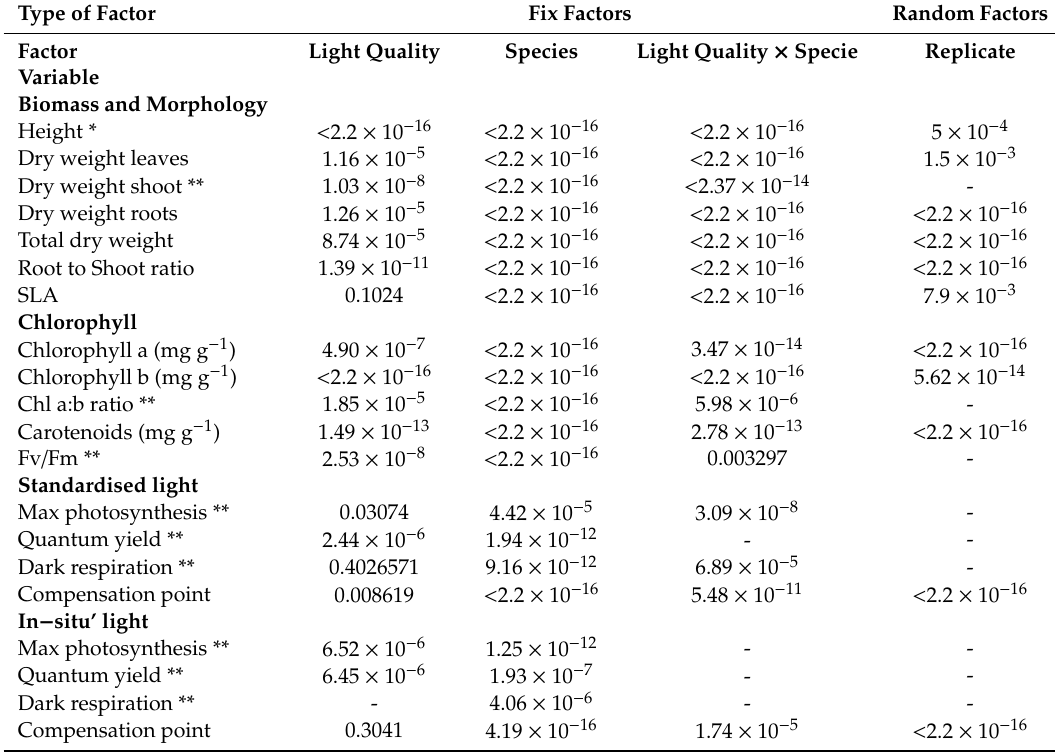
Table 2. p -values derived from the full-factorial ANOVA analyses of the di ff erent measured plant traits, with light treatment and species as fixed factors, and the replicates of the individual light treatments as random factors. Non-significant p -values ( ≥ 0.05) are indicated as